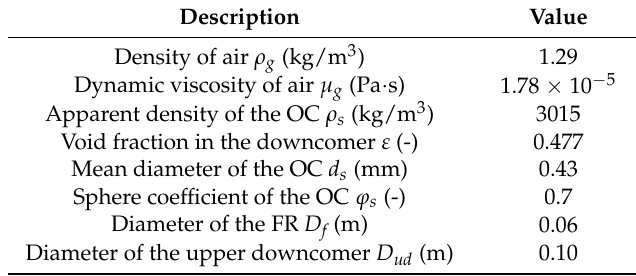
Figure 5. Comparison of predicted and experimental upper pressure gradients under ideal sealing states with different solid circulation fluxes. Table 1. Parameters for the calculation of the ideal upper pressure gradient (OC: oxygen carrier; FR: fuel reactor).